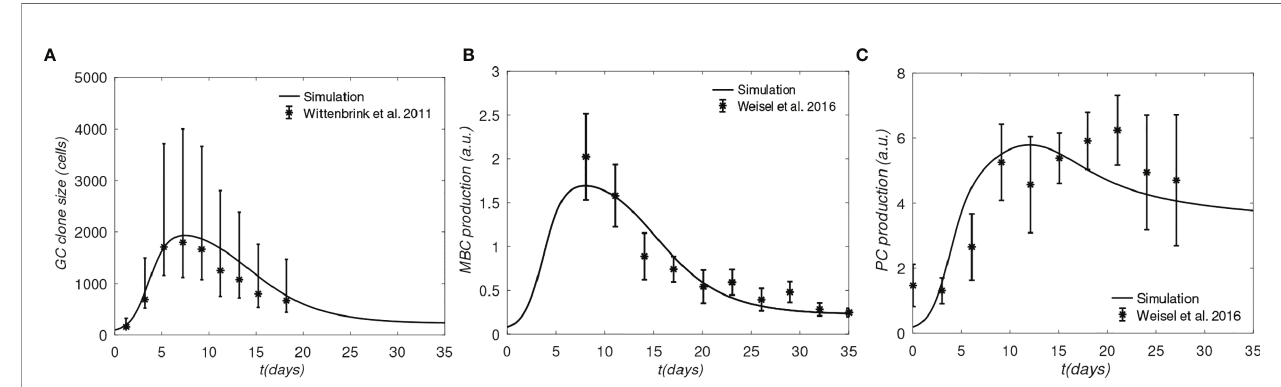
FIGURE 3 | Comparison of simulation and experiments. (A) Total B-cells, (B) Memory B-cell production rate, (C) Plasma cell production rate. Experimental data for panel A was generated from the GC cross-sectional areas plotted in Figure S1B of (42), and converted to B cell counts as done in (43); The lower and upper error bars in panel (A) corresponds to 30% and 70% quantiles, respectively; experimental data for panels (B, C) was taken from Figure 4 of (43), who obtained raw data from Weisel et al. (44); the error bars in (B, C) correspond to approximately